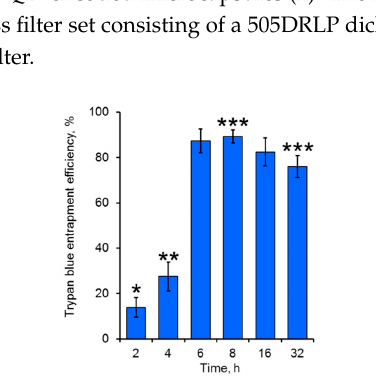
Figure 2. E ffi ciency of the microcapsule staining using trypan blue: * the data are significantly di ff erent Figure 2. Efficiency of the microcapsule staining using trypan blue: * - the data are significantly different from 4, 6, 8, 16, 32 h (P < 0.05); ** - the data are significantly different from 6, 8, 16, 32 h (P < from 4, 6, 8, 16, 32 h ( p < 0.05); ** the data are significantly di ff erent from 6, 8, 16, 32 h ( p < 0.05); *** the 0.05); *** - the data are significantly different from 8 and 32 h (P < 0.05). data are significantly di ff erent from 8 and 32 h ( p <